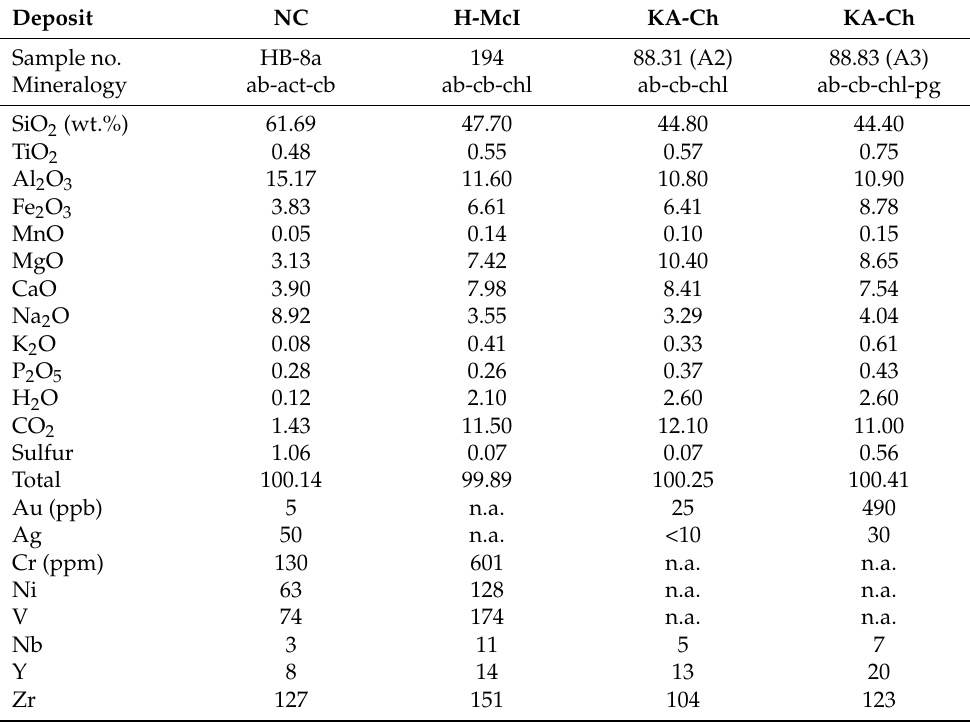
(Table 2) based on crosscutting relationships and wall-rock xenoliths including fragments of auriferous veins. Most plot in the calc-alkaline andesite field of the Zr/TiO 2 versus Nb/Y diagram [2]. Some A1-dykes are spotted pink and contain minor anhydrite. The dyke swarm plunges steeply east and converges towards the Chesterville Plug, a lens- shaped intrusion 40 × 120 m in plan section, which is continuous from 180 m to 2000 m depth [2,53]. Table 2. Whole-rock analyses of albitite dykes in the New Celebration (NC), Hollinger-McIntyre (H-McI), and Kerr Addison-Chesterville (KA-Ch) gold deposits. Deposit NC H-McI KA-Ch KA-Ch Sample no. HB-8a 194 88.31 (A2) 88.83 (A3) Mineralogy ab-act-cb ab-cb-chl ab-cb-chl ab-cb-chl-pg SiO 2 (wt.%) 61.69